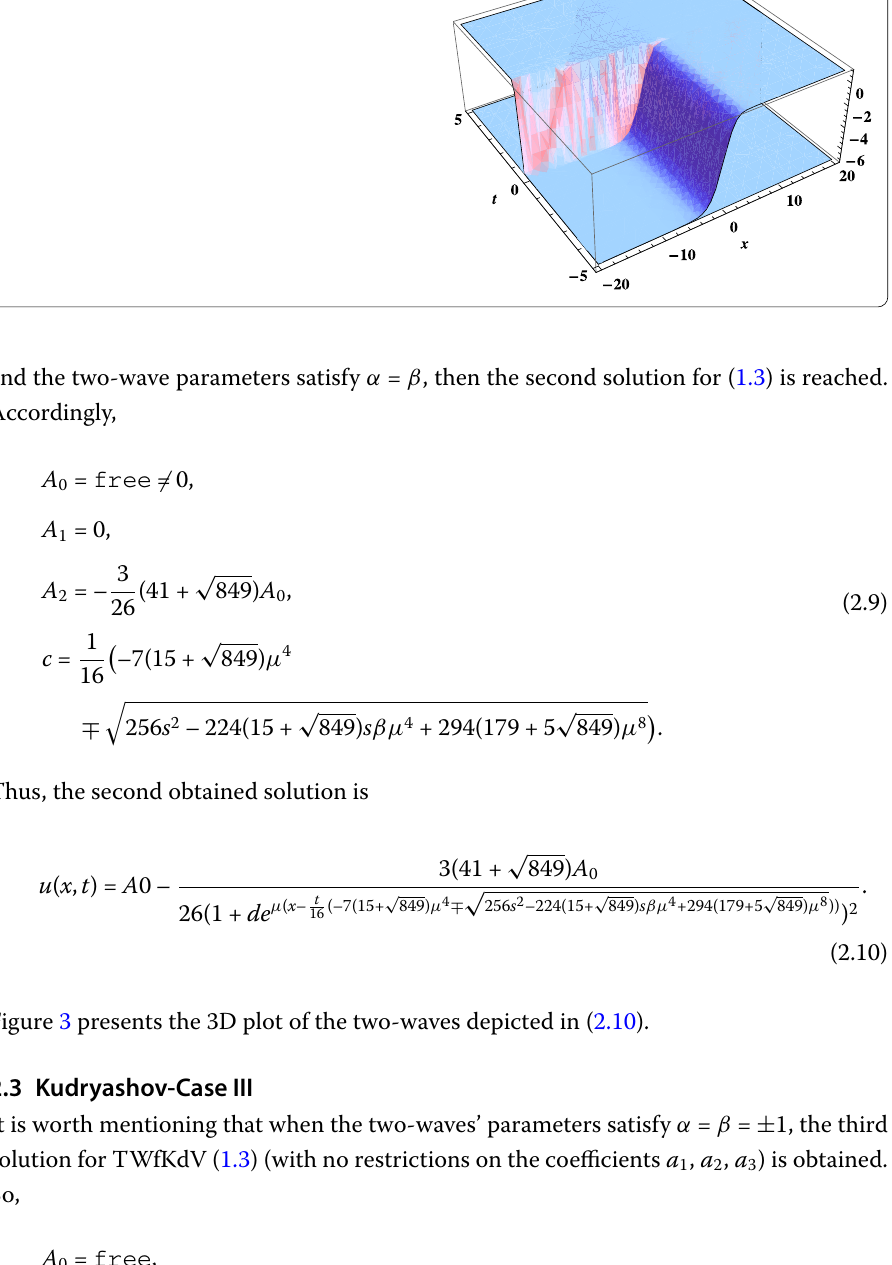
Figure 3 The two-waves depicted in (2.10) with β = 0.1, s = d = μ = A 0 = 1